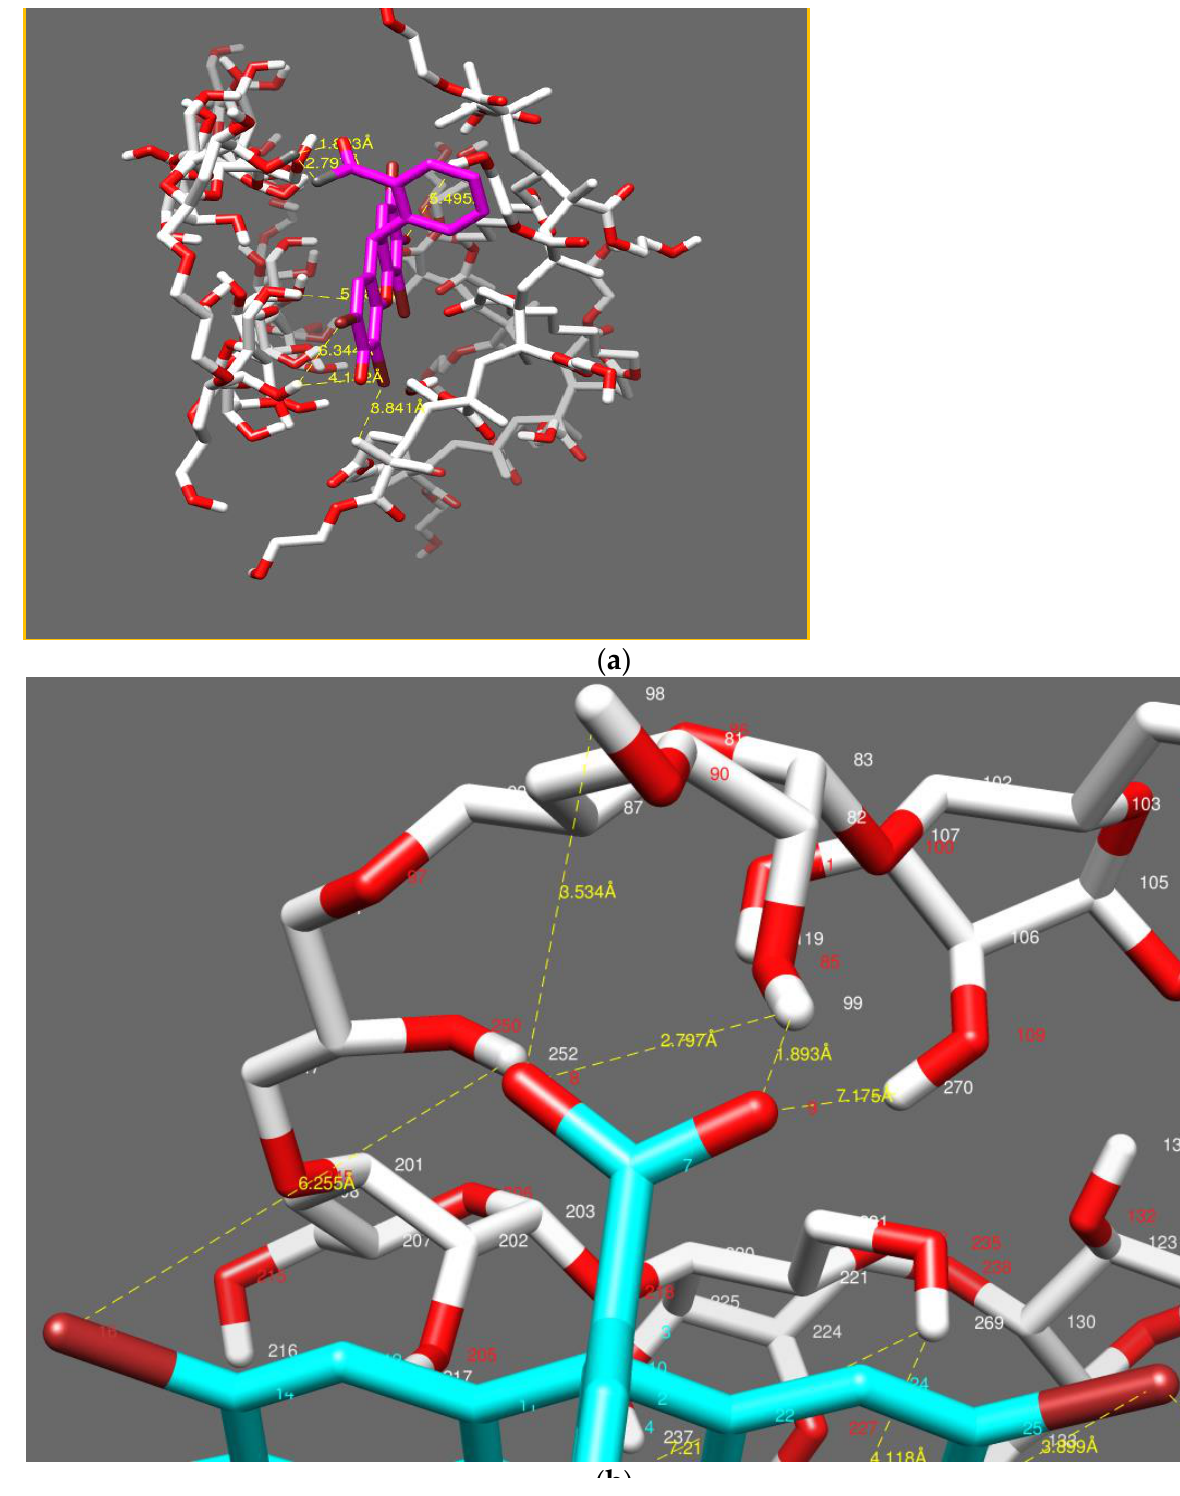
Figure 18. Representation of interactions in the system IPN (cellulose–polyHEMA hydrogels)/eosin Y ( a ). Aggrandizement of interactions ( b ).